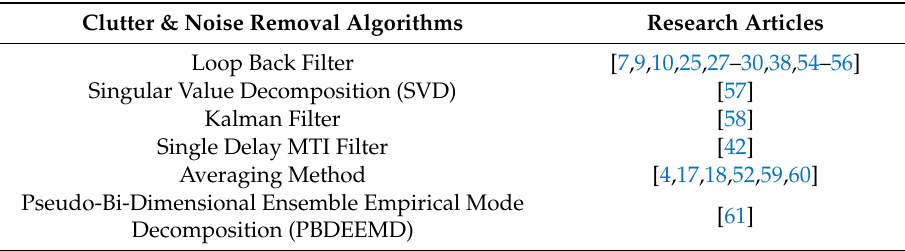
Table 1. Clutter removal algorithms for vital sign